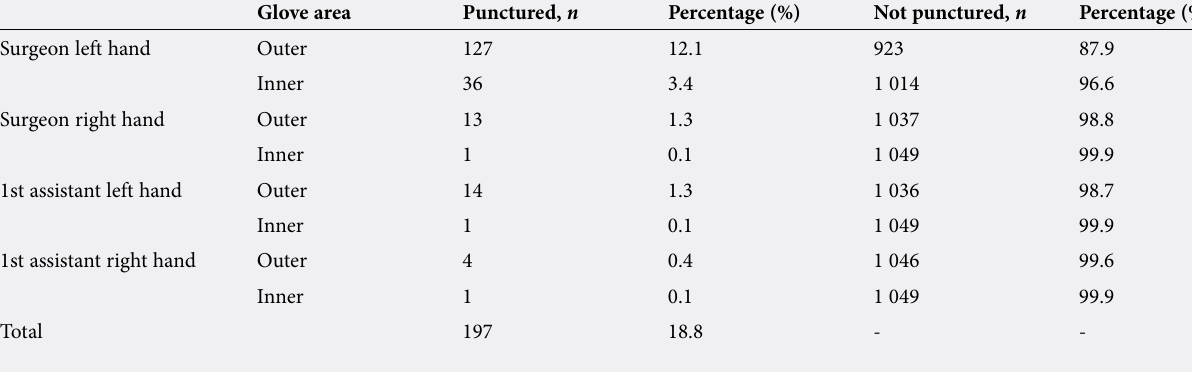
Table 4. Pattern of glove puncture injury in surgeon and assistant